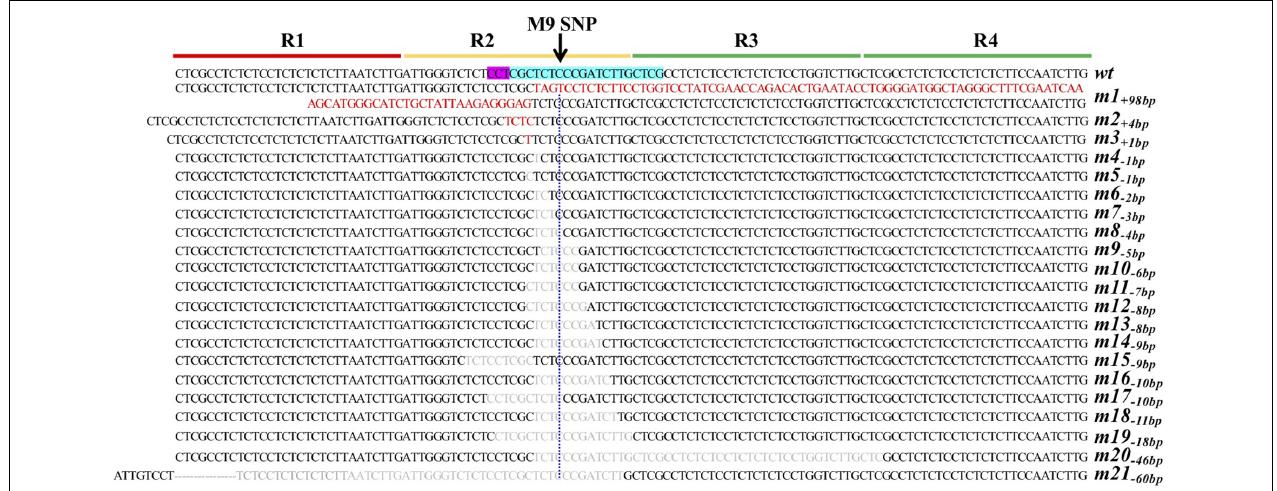
FIGURE 2 | CRISPR/Cas9-induced mutations in LA1589. PAM and gRNA are highlighted in pink and cyan, respectively. The four tandem repeats in promoter were indicated by R1, R2, R3, and R4. The black arrow and blue dashed line indicate the position of the M9 SNP in LA1589 and all the 21 mutants, respectively. Inserted and deleted nucleotides were shown in red and gray, respectively. m, mutant allele. The mutant alleles were numbered 1 through 21 according to the length of the alleles. For the subscripts of the mutant alleles, (-) indicates deletions followed by the number of bp deleted, (+) indicates insertions followed by the number of bp inserted.